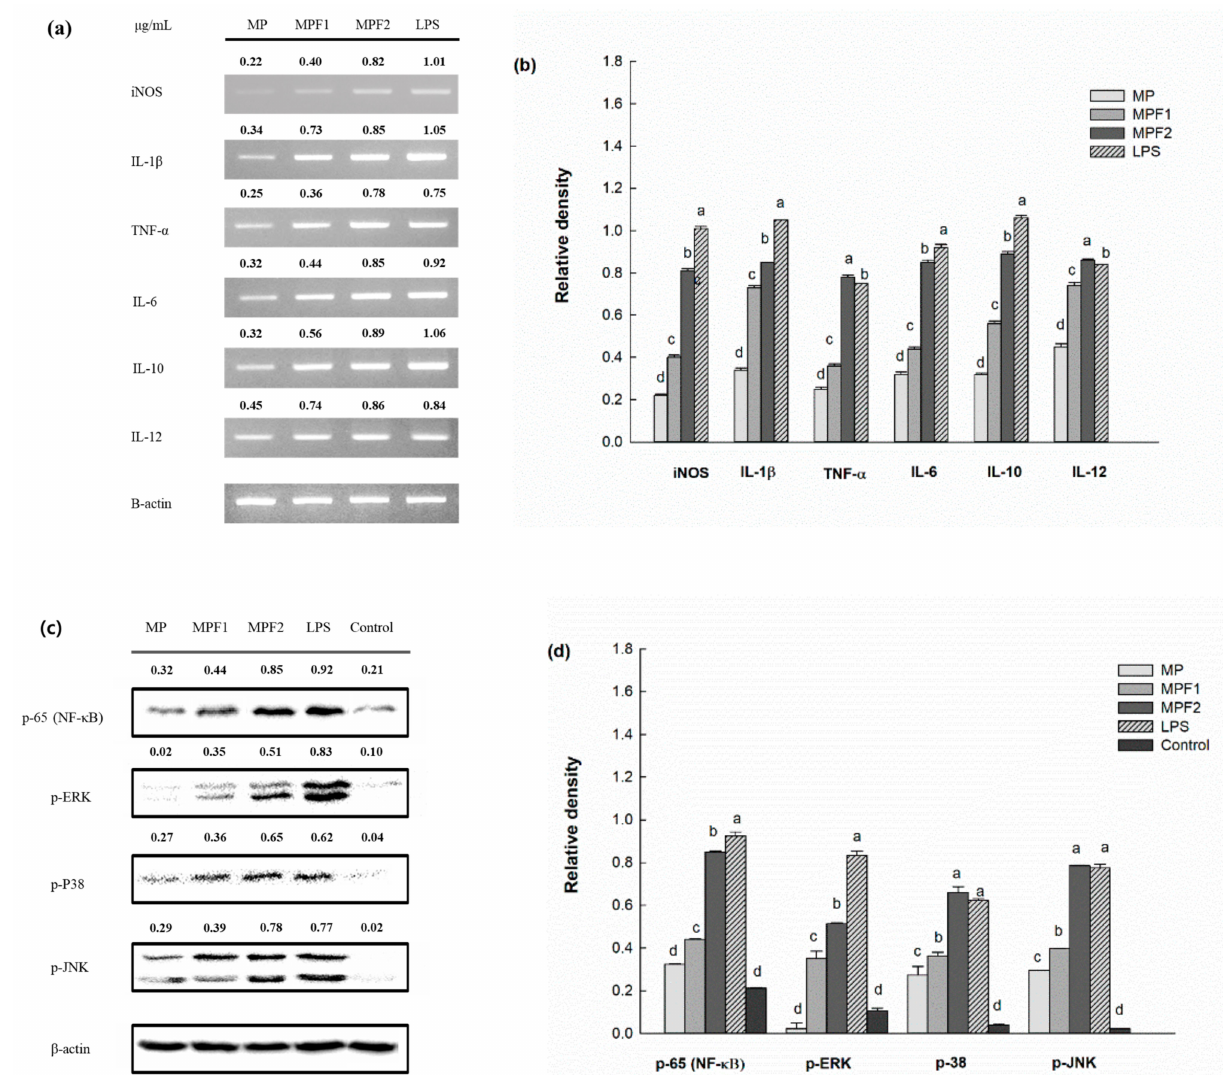
Figure 3. Effects of MP, MPF1, and MPF2 from A. hemibapha subspecies javanica on cytokine mRNA expression in RAW264.7 cells ( a ), and the relative band intensity ( b ). Phosphorylation of p65, ERK, P38, and JNK by MP, MPF1, and MPF2 ( c ), and the relative band intensity ( d ). Different letters a,b,c,d indicate a significant difference ( p < 0.05) among the MP, MPF1, and